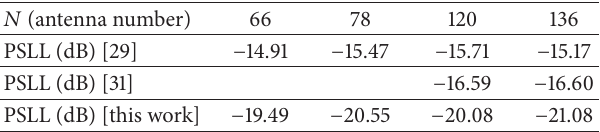
Table 3: Peak sidelobe levels for square arrays of 12×12 and 16×16